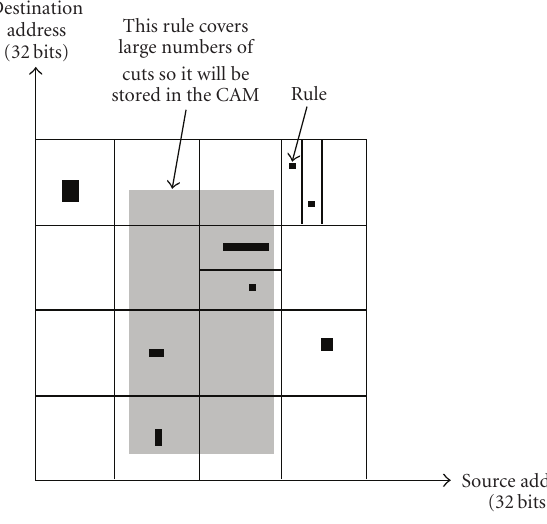
Figure 12: Some rules are redundant in many